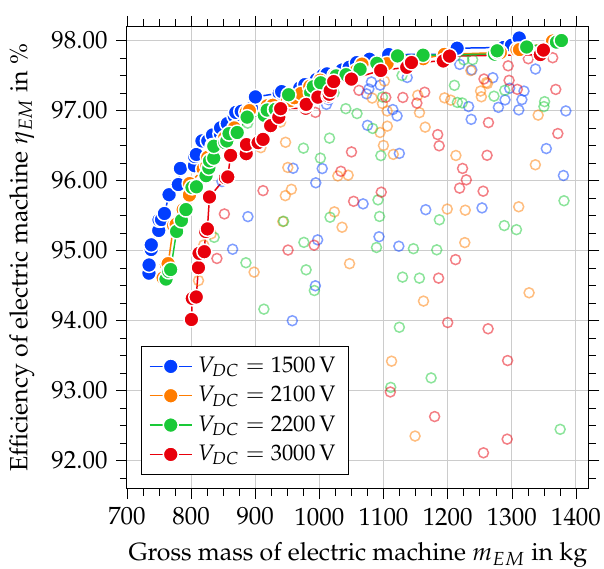
Figure 4. Gross mass against efficiency of electric machine for different DC link voltage levels V DC ( P EM , shaft = 8.0MW, n EM , shaft = 2100min − 1 , J ef f = 17.5Amm − 2 and f EM , el = 420–1750 Hz). Line plots indicate Pareto-fronts for different voltage levels. Not all results shown for better readability ( ≈